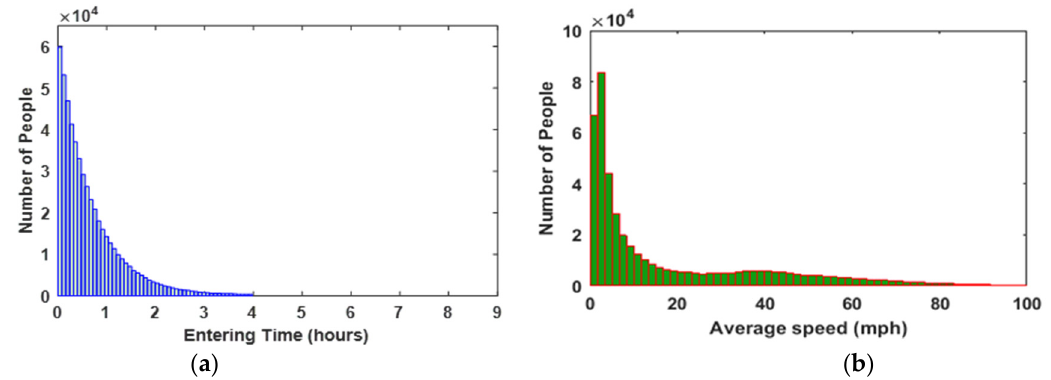
Figure 8. ( a ) Number of people entering the system vs. time (hours) ( b ) Overall average speed for the population during the evacuation simulation (T.Ts = 1 s).